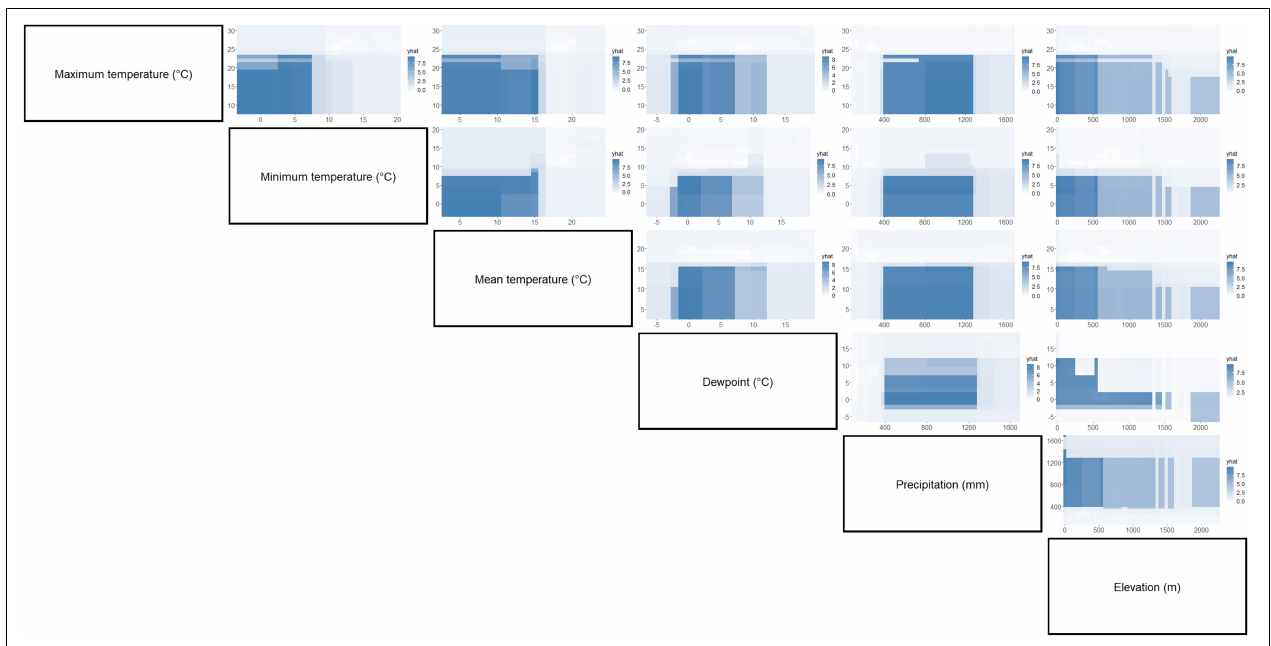
FIGURE 7 | Partial dependence plots of paired environment parameters showing their association with C . quinquefasciatus occurrence. Intensity of color is proportional to partial dependence of C . quinquefasciatus occurrence on various climate factors.